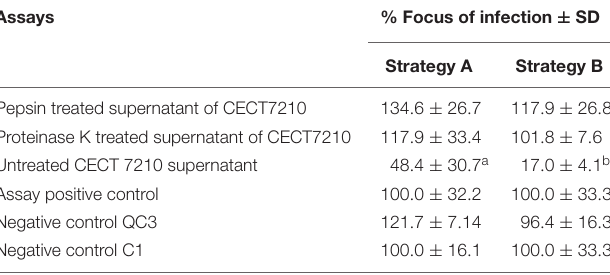
TABLE 2 | Assay for in vitro activity against human rotavirus SA11 in MA-104 cell line in supernatants obtained with the growth of B. longum subsp. infantis CECT 7210, and